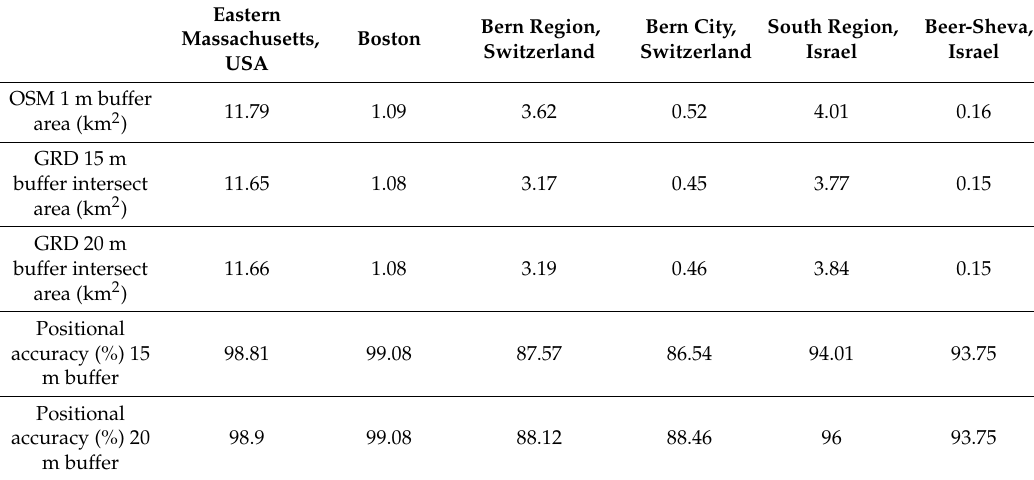
Table 4. OSM Positional Accuracy (PA)